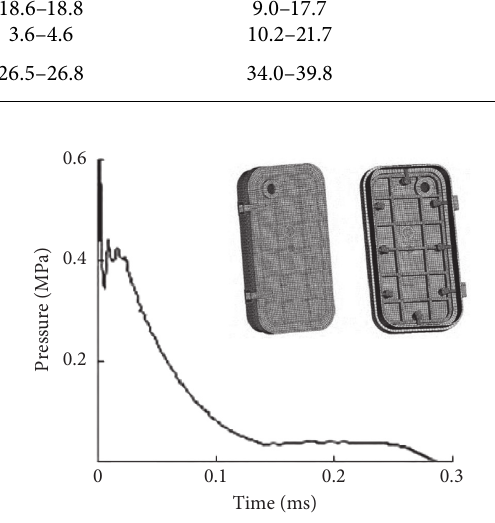
Figure 4: Shock wave pressure curve of the protective closed door [36].